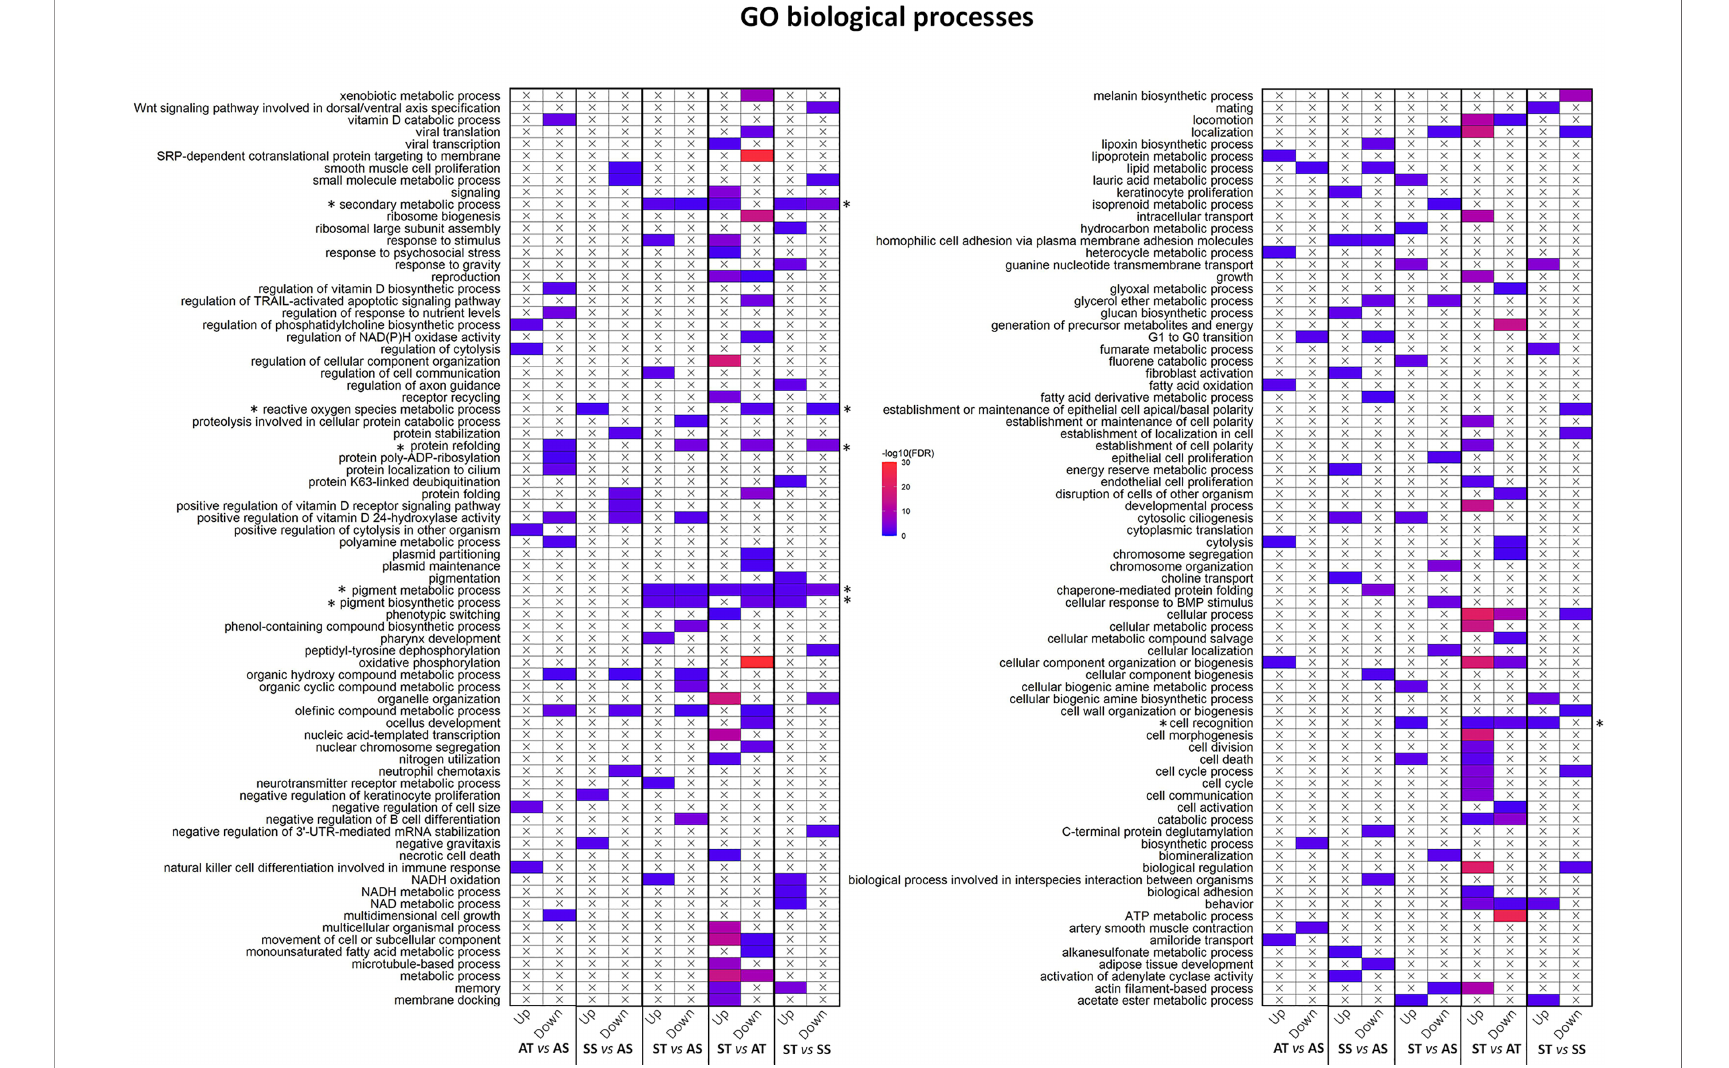
FIGURE 8 | Changes in hemocyte gene expression in response to TCAP/FSSW and ambient/stress treatments. Plots showing the over-represented biological processes in the upregulated and downregulated DEG list in response to TCAP/FSSW and stress/ambient (transcriptome comparison). Each row represents a GO term category, and each column represents the treatment replicates. The most representative and signi fi cant biological processes are shown. The colour depicts the signi fi cance of the enrichment (-log10 (FDR-corrected P -values)). The X mark in the cells means that the GO term is not a representative term in the corresponding DEG list in a comparison. Asterisks represent enriched GO terms of